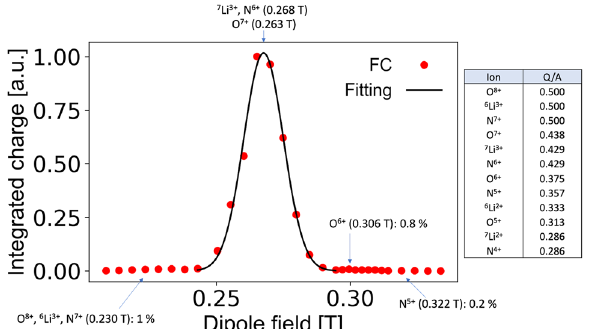
Figure 5. Spectrum of beam constituents obtained by scanning the dipole magnet field. The peak at 0.268 T corresponds to 7 Li 3+ and N 6+ . The width of the peak depends on the beam size at the slit. Despite the peak width,